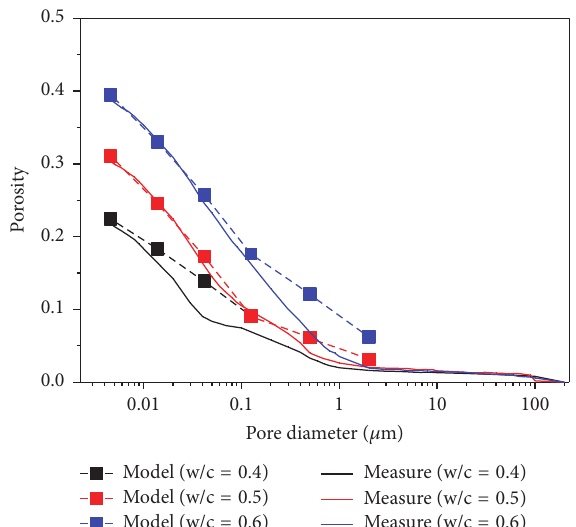
Figure 7: Modeled and measured pore size distribution of cement pastes with varying w/c ratios.